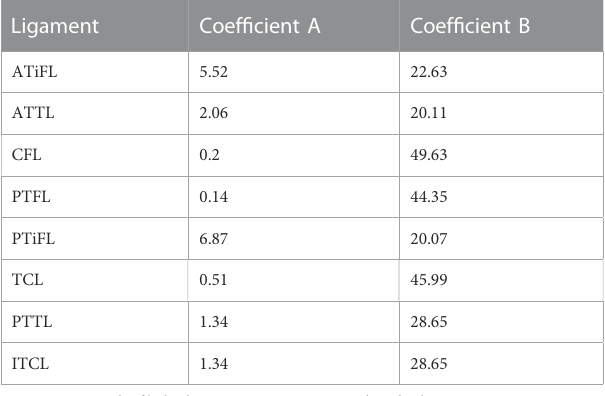
TABLE 2 Material coef fi cient of eight ligaments. Ligament